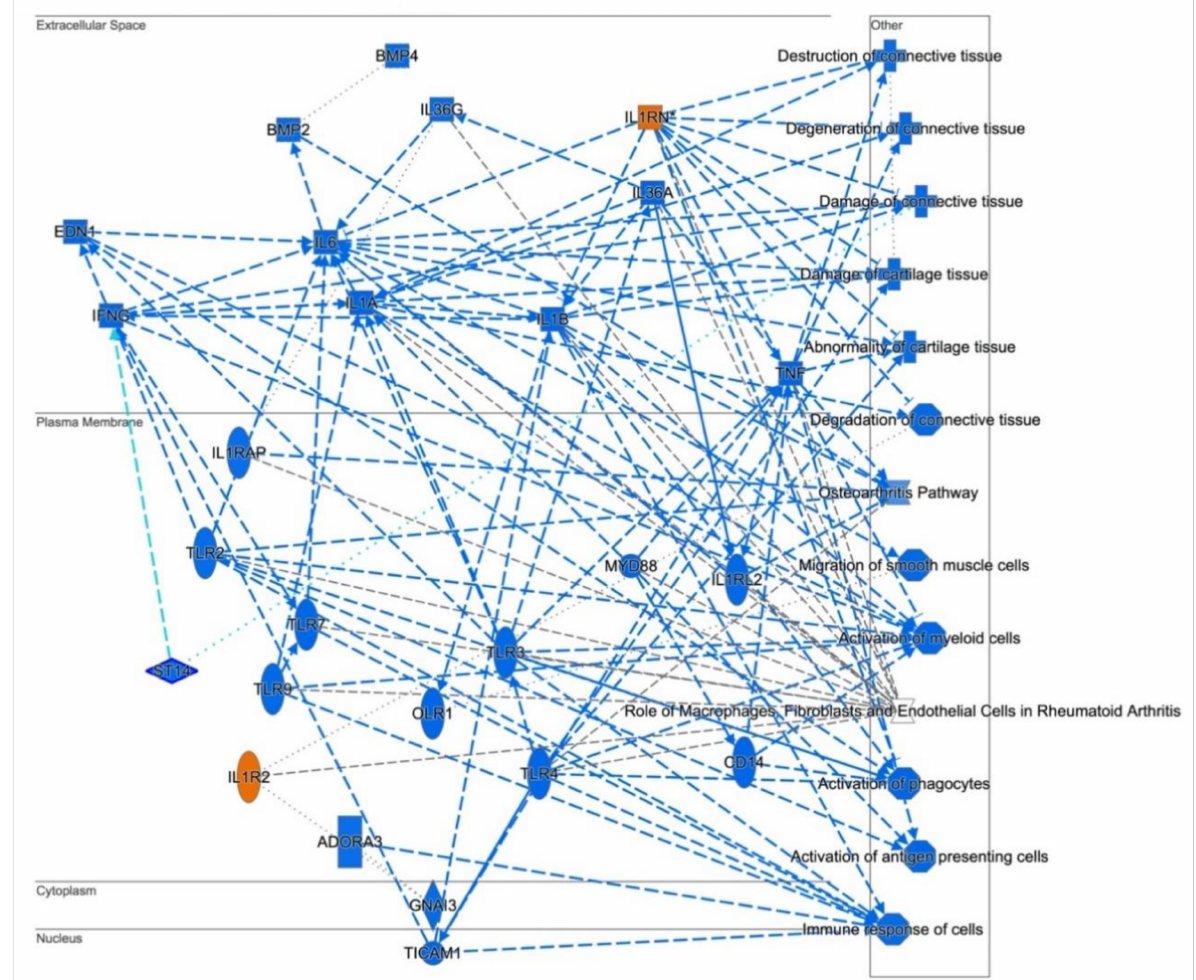
Figure 6. Graphical summary of human skin fibroblast profiling of SS patients. The Ingenuity Pathways Analysis showed that deficiency of TWIST2 activity impacts connective tissue, importantly in its destruction, degeneration and damage repair. Includes all entities with p < 0.05 and z score ≥ 2 for diseases, functions and upstream regulators. Orange entities repre-sent activated nodes with z score ≥ 2, while blue entities represent inhibited nodes with z score ≤ − 2. Ellipses represent transmembrane receptors, diamonds = enzymes, squares = cytokines or growth factors, rectangles = G-protein coupled receptors, octagons = function, crosses = disease, squeezed rectangle = canonical pathway and circles =